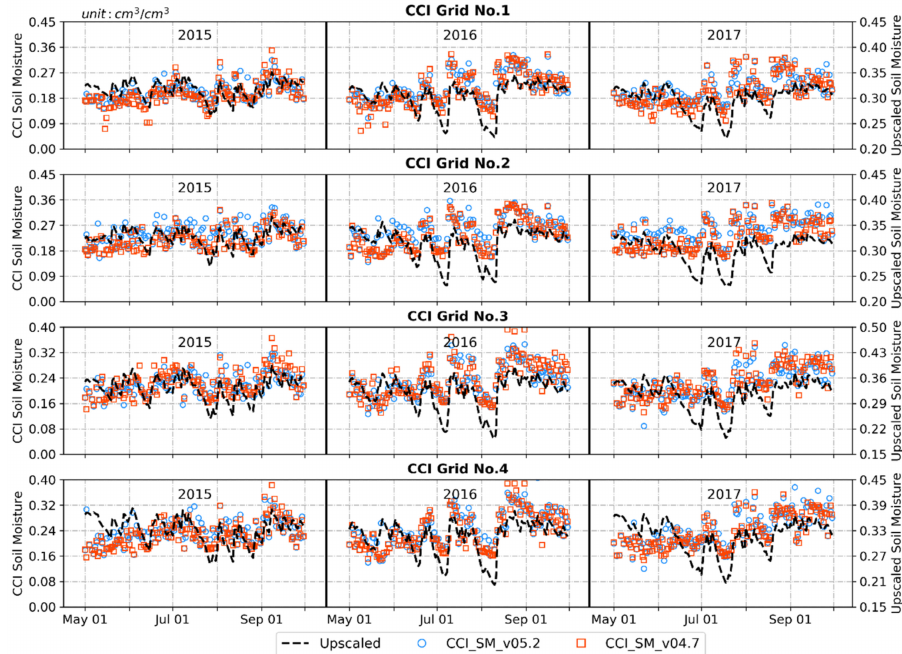
Figure 12. Temporal comparisons between the upscaled SM and CCI products with different versions at the 0.25 ◦